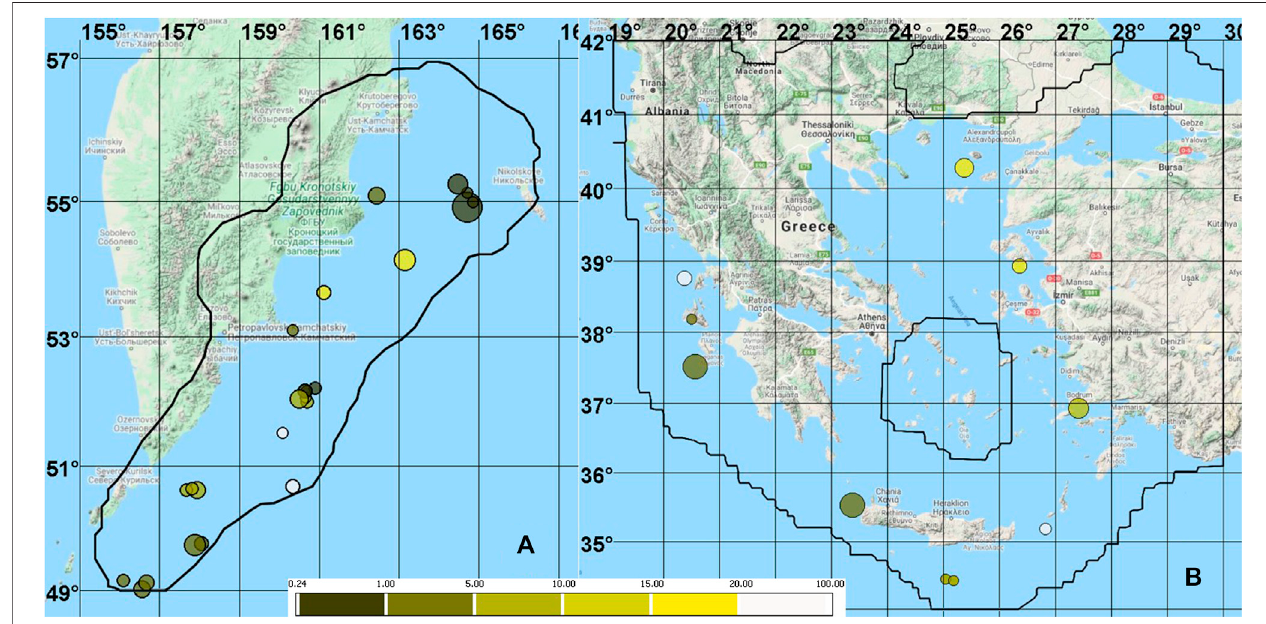
FIGURE 1 | The maps of epicenters of the target earthquakes in the test sample color-coded with respect to the volume of alarm required for its successful prediction: (A) 24 magnitude m ≥ 6 . 0 earthquakes in Kamchatka and (B) 10 magnitude m ≥ 5 . 9 earthquakes in the Aegean Region. The outline highlights areas of analysis. The circles show the epicenters of the test earthquakes. The size of the circles increases with the magnitude of the earthquake. The intensity of the shading of the epicenters decreases with an increase in the volume of alarm with which the epicenter is predicted: 1, 5, 10, 15, 20%. The white color indicates a forecast skipping